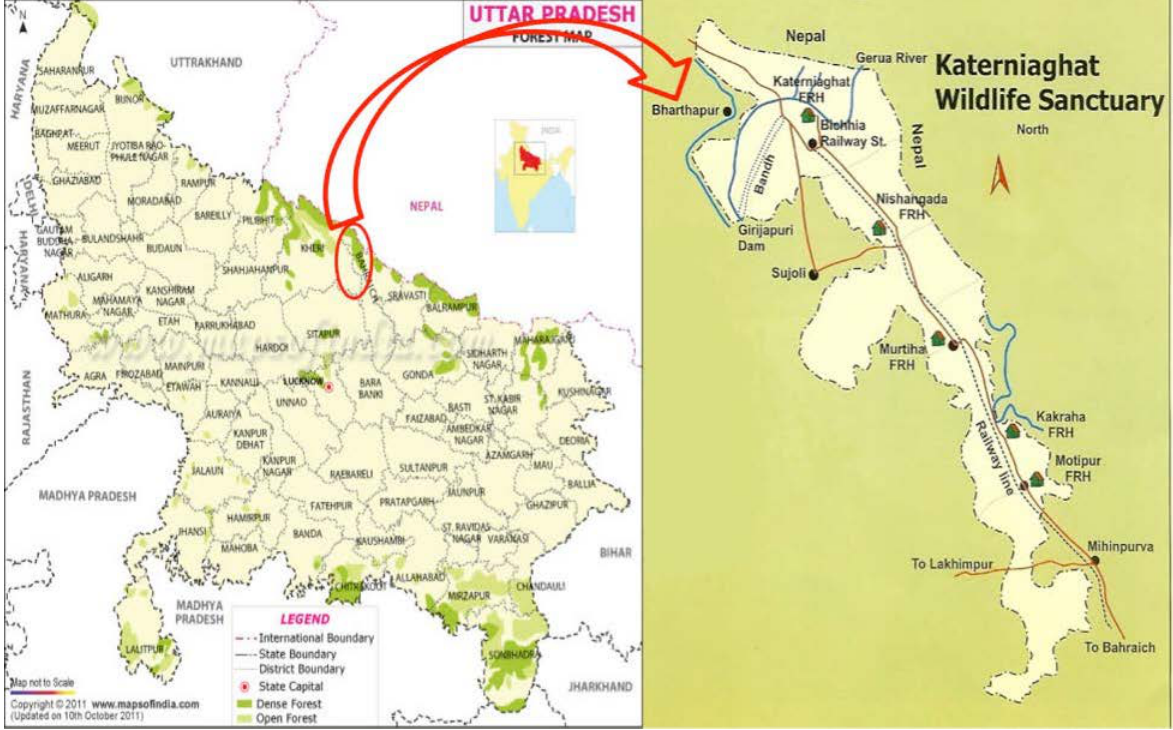
Figure 1. Location of Katerniaghat Wildlife Sanctuary in Uttar Pradesh. Source: Uttar Pradesh map from http://www.mapsofindia.com/maps/ uttarpradesh/uttarpradesh-forest-map.htm and KWS from: